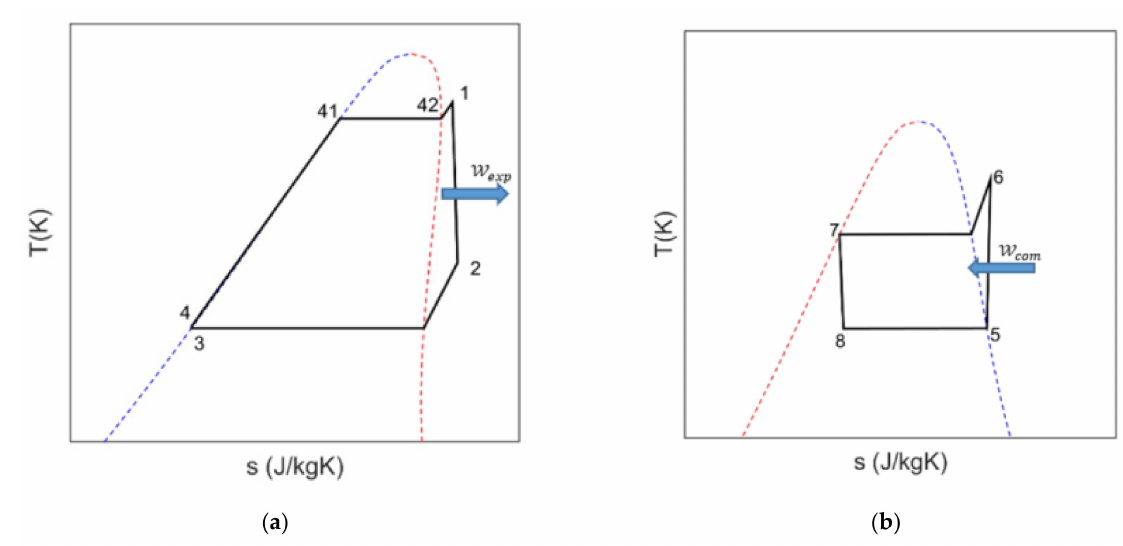
Figure 2. Temperature-entropy diagram for ORC ( a ) and VCC ( b ).